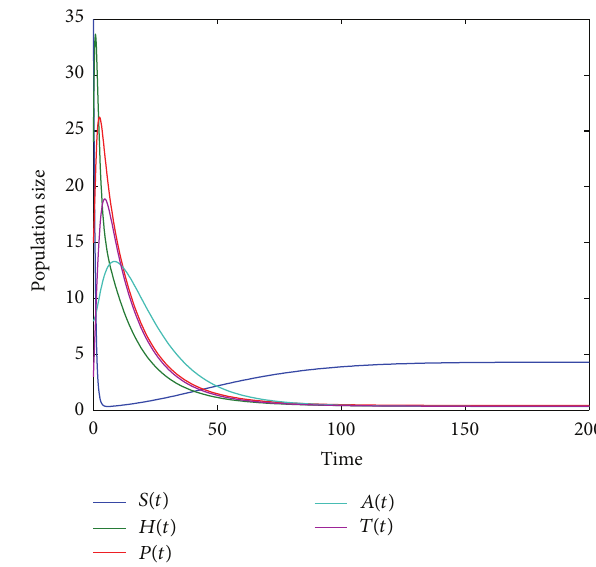
Figure 2: When 𝑘 3 = 0.6 , 𝑘 4 = 0.4 , and 𝑅 0 = 0.95047 < 1 , the disease-free equilibrium is globally asymptotically stable.